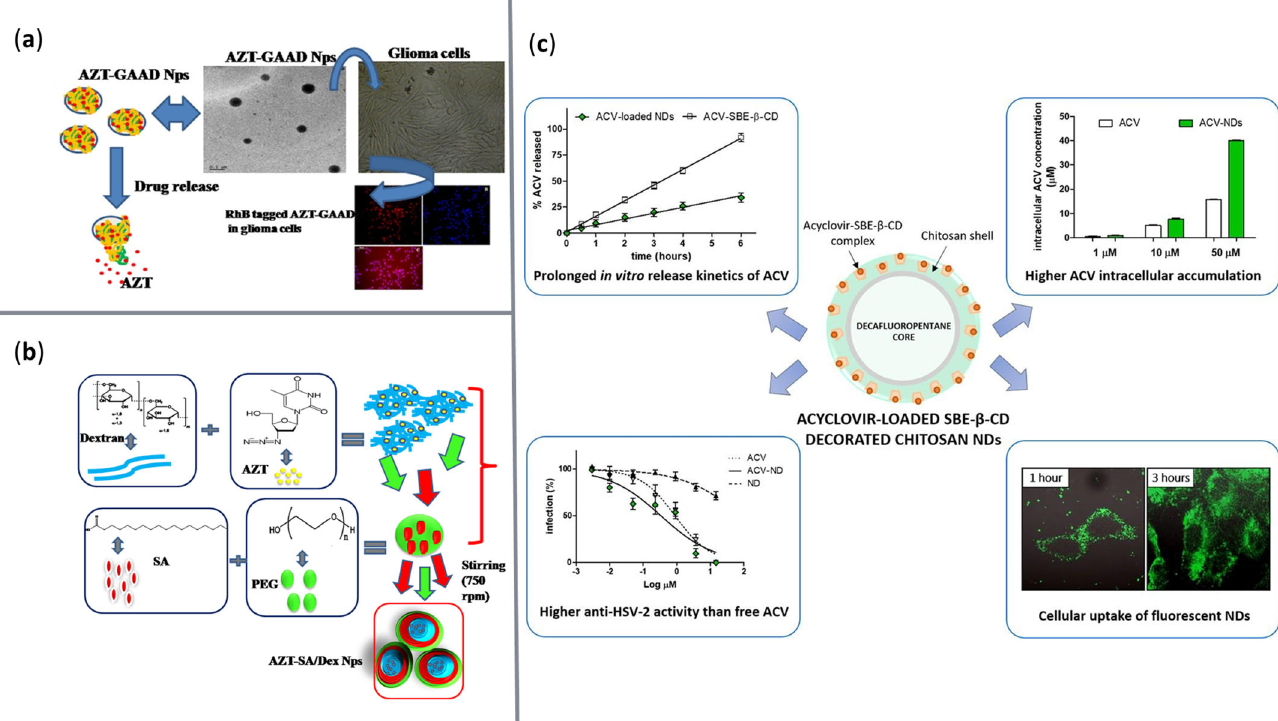
Figure 8. Visual representation of several nanosystems for antiviral agents’ delivery. ( a ) Amide-functionalized alginate NPs loaded with zidovudine. Reprinted with permission from [127], © Elsevier, 2018. ( b ) Dextran-stearic acid core shell NPs loaded with zidovudine. Reprinted with permission from [128], © Elsevier, 2018. ( c ) Sulfobutyl ether- β -cyclodextrin decorated chitosan nanodroplets for acyclovir delivery. Reprinted with permission from [131], © Elsevier, 2020.